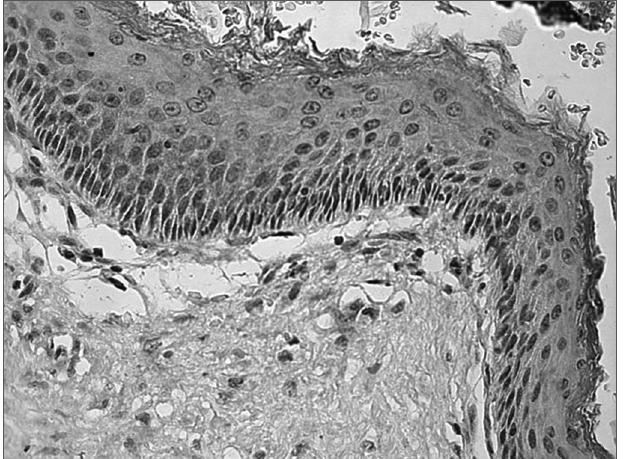
Figure 2. Microphotography of the cholesteatoma fragment, in which we notice moderate reaction against the TNF-R2 receptor in the cyto- plasm of the matrix keratinocytes (IHQ X400).